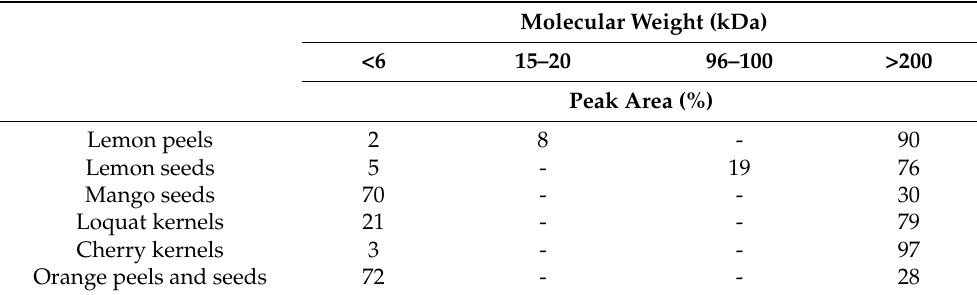
Table 3. Molecular weight distribution (Peak Area %) of soluble fibre extracted by EAE from different fruit